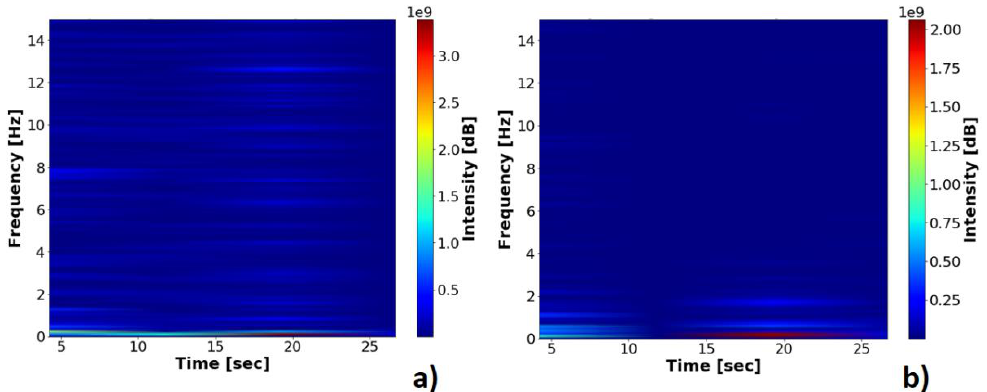
Figure 12. Spectrograms of the area vectors between the markers: ( a ) Probe in dynamic operation; ( b ) Probe in static operation.